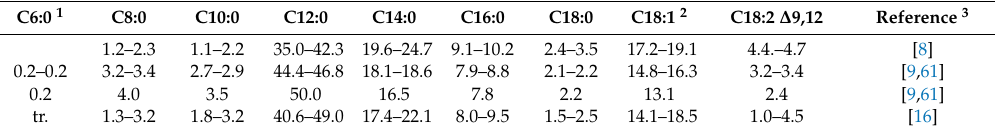
Table 2. Fatty acid composition (% w / w ) of mesocarp oil from interspecific